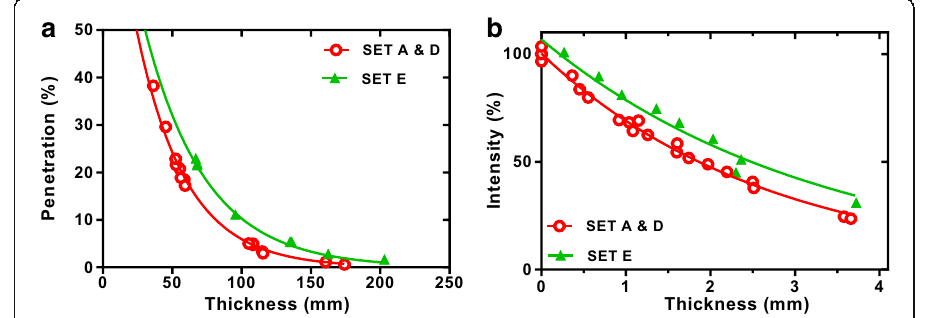
Fig. 9 Beam intensity through different thicknesses of SLM tungsten printed with different scan strategies and different beam intensities a 140 keV, b 364 keV data fitted using least squares regression